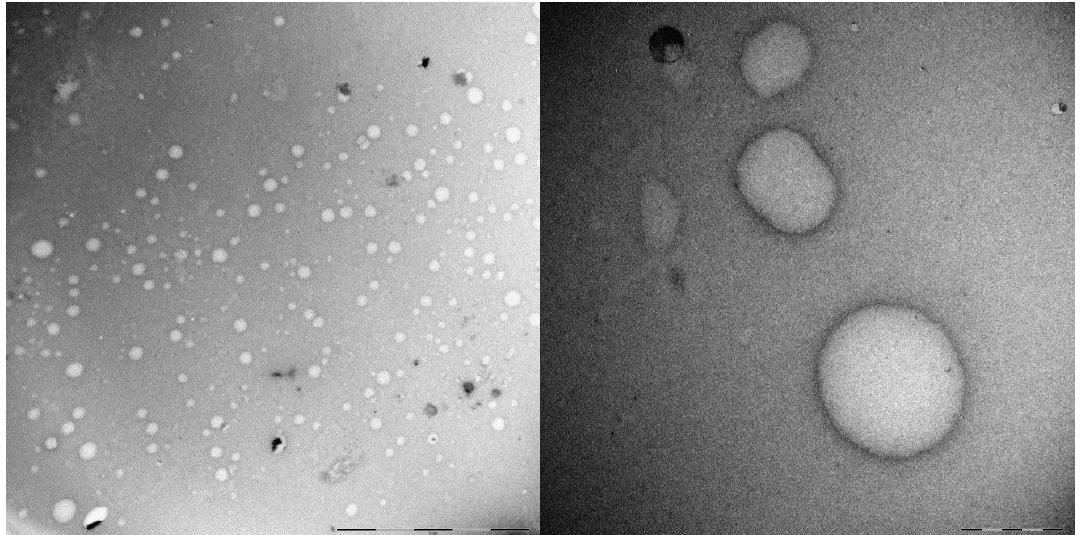
Figure 12. Structure of macromolecular aggregates found by TEM analysis of poly-6-MOEG-9-T- BF3k -FE solutions in water. The scale bar corresponds to 1 μm in the left panel and 200 nm in the right panel.